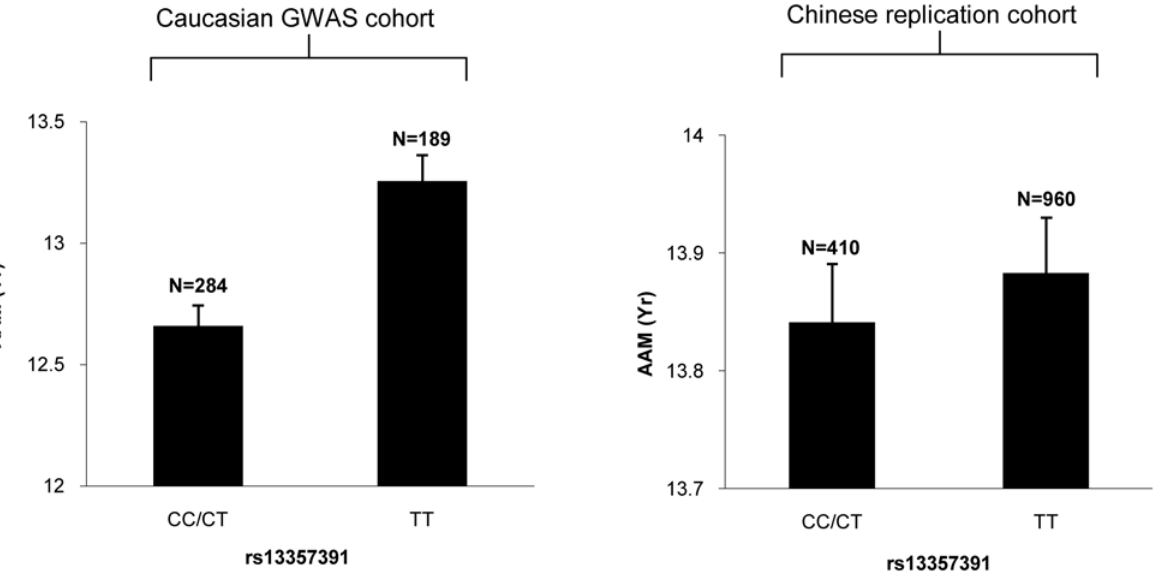
Figure 3. Comparison of AAM among subjects of different genotypes at rs13357391 . Presented in the figure are the means and standard errors of AAM for specific genotype groups in the GWAS and Chinese replication